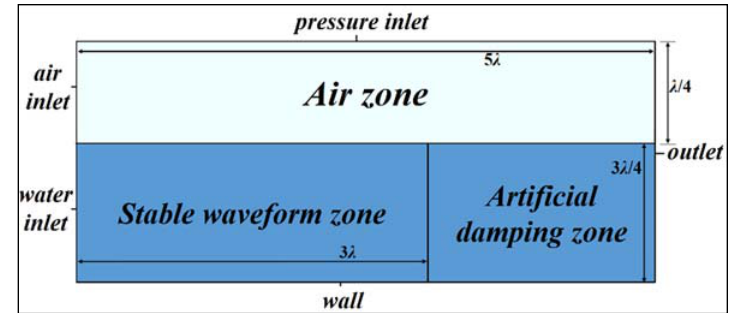
Figure 2. Schematic diagram of numerical wave tank.